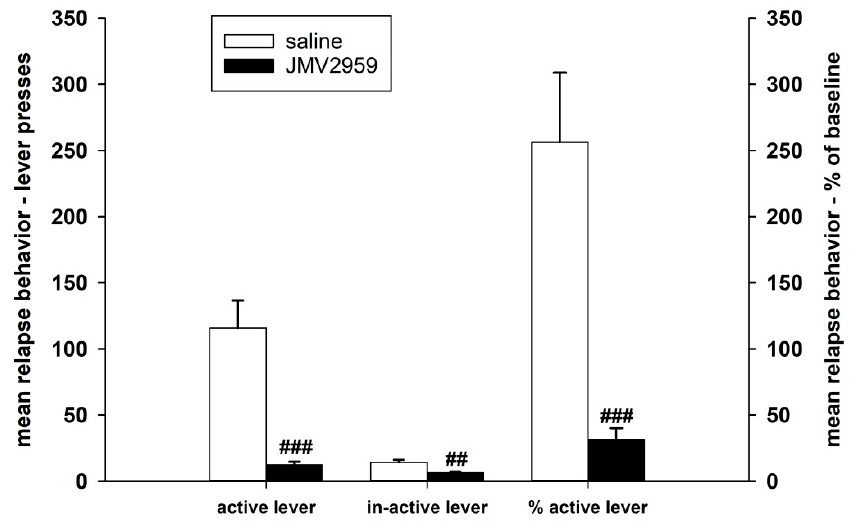
Figure 10. JMV2959 pretreatment effects on lever-pressing relapse-like behavior, observed after the 10–12th day of abstinence of the methamphetamine IVSA. JMV2959 3 mg/kg or saline were administered i.p. 20 min before the session. Means of the groups are presented ± SEM; N = 12 (JMV2959 group), N = 8 (saline group); Kruskal–Vallis ANOVA was used for the statistical analysis of the absolute data or the percentage of baseline means. The effects are shown as follows: saline (open bar), JMV2959 (filled bar). Differences between groups are expressed as ## p < 0.01, ### p < 0.001.